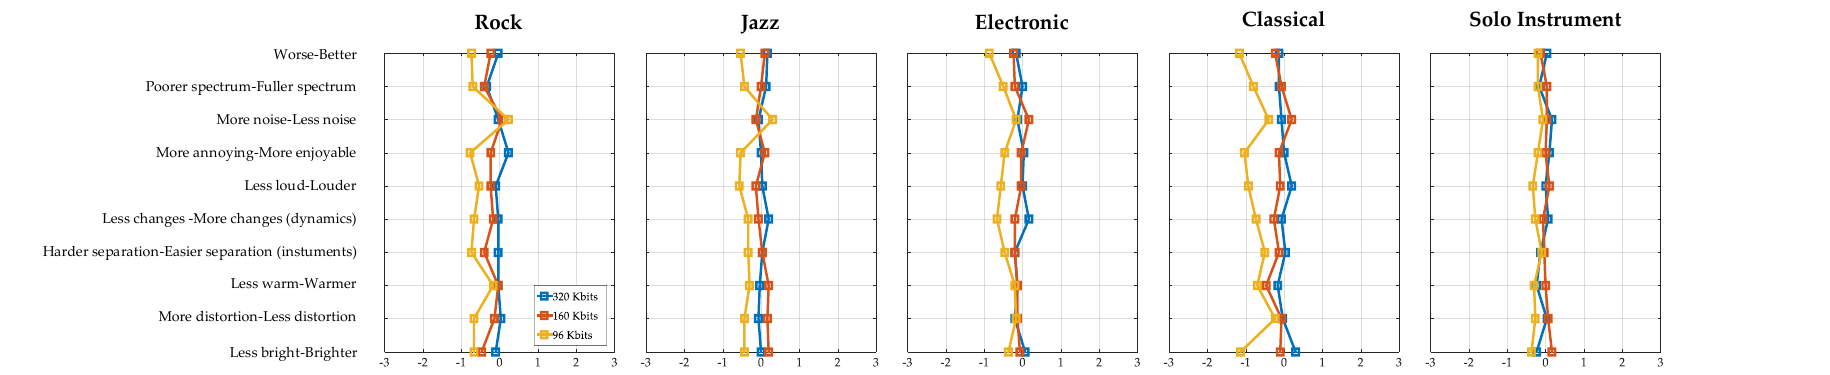
Figure 4. Average evaluation scores for the bipolar scales for each music genre